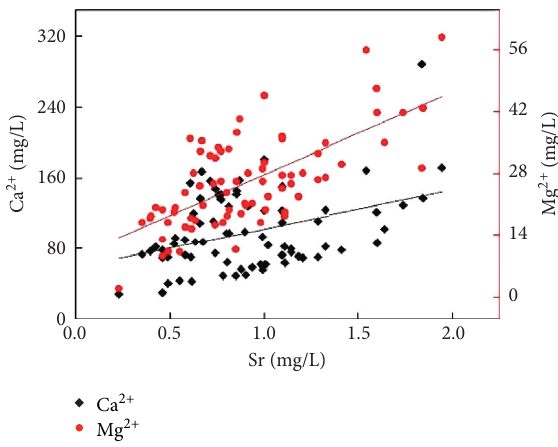
Figure 8: Relationship between strontium, calcium, and magne- sium contents in